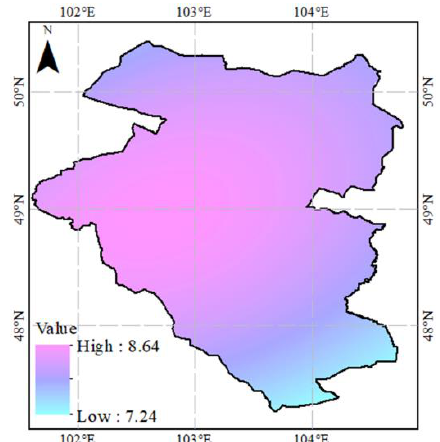
Figure 4. Spatial distribution map of aridity index for the period.